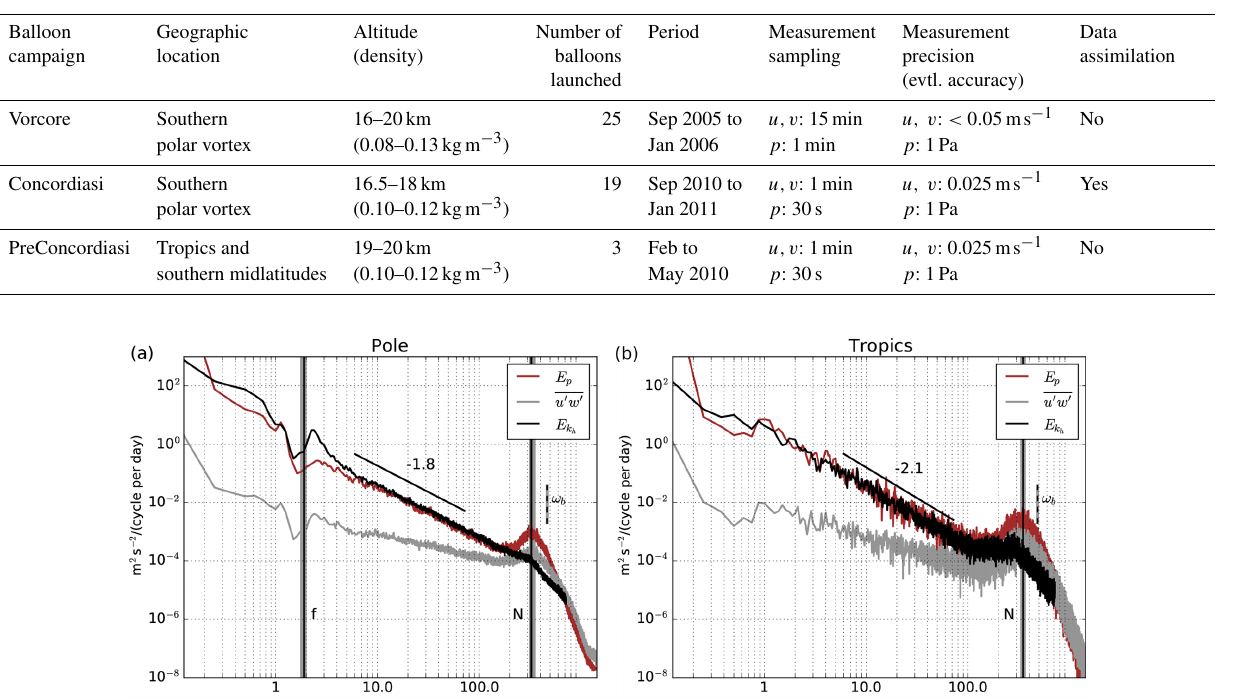
Table 1. Balloon measurement campaigns used as the observational reference for this study. The last column (data assimilation) reports whether or not the data were broadcast on the Global Telecommunication System.